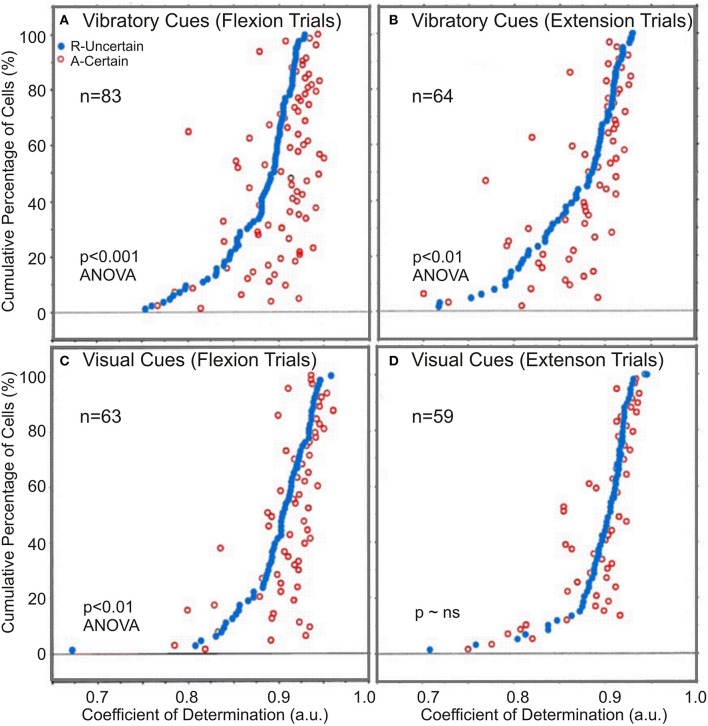
The comparison of regression coefficients. Paired coefficients of determination, CoDs, for both vibratory and visually cued trials: (A,B) Certain “A” and uncertain “R” rewarded trials for vibratory cued trials and (C,D) for visually cued trials. In both instances, CoDs of the uncertain R trials (black dots) were arranged in ascending order from left to right. The certain trial CoDs corresponding to each uncertain trial CoDs were plotted at the appropriate height. Open dots to the right of the black dots indicate instances where the neuronal activity was better related (CoDs were greater) for movements made in the certain reward A trials.